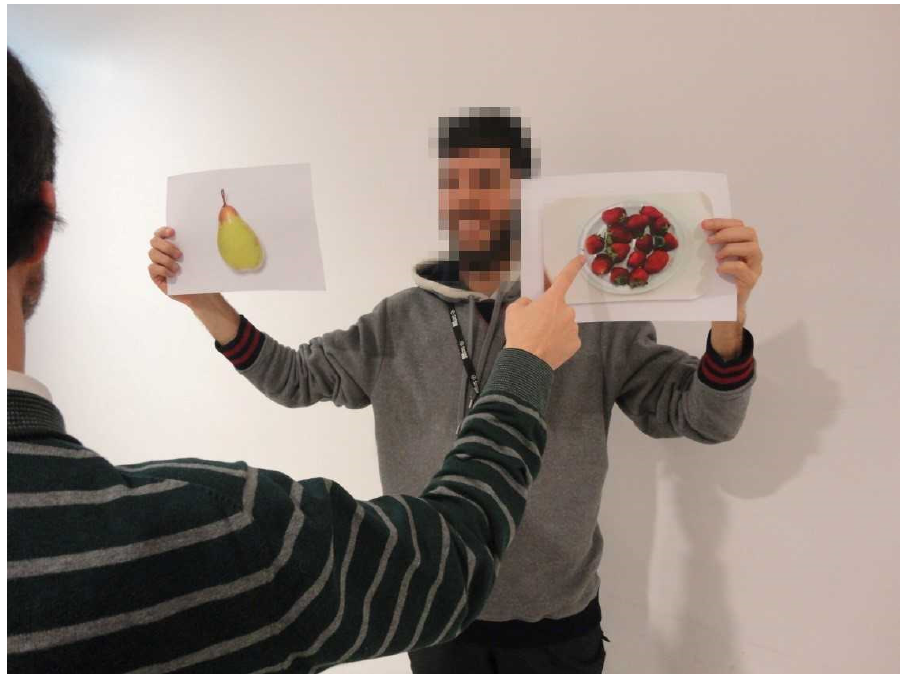
Figure 6. Multiple choice answer during walking exercise. Participants were asked to select, among two, which foods had more sugar, fat, saturated fat, glycemic index, or glycemic load.